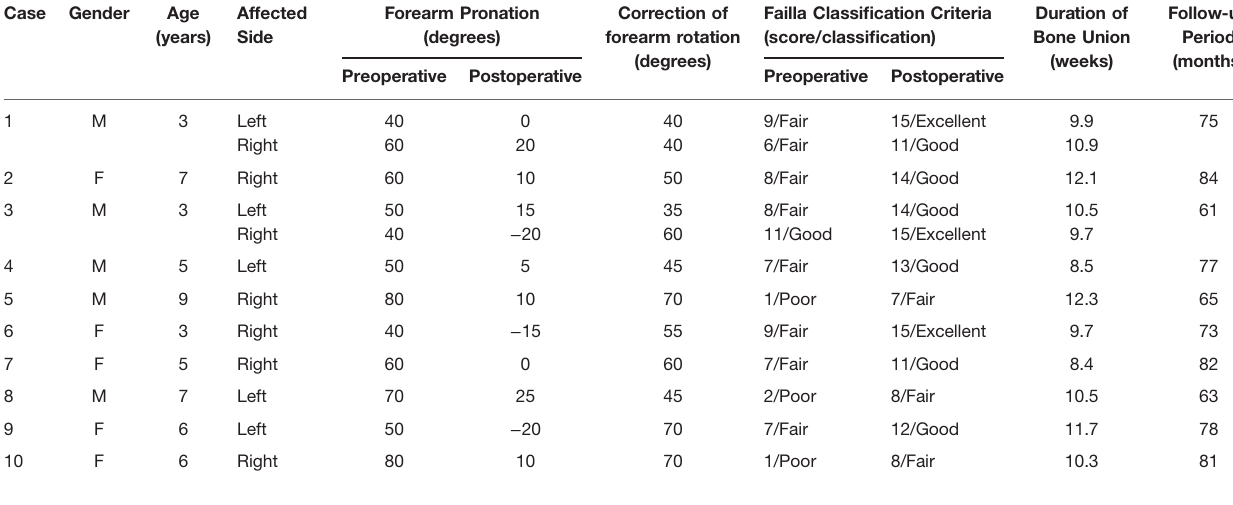
TABLE 1 | Individual patient data.